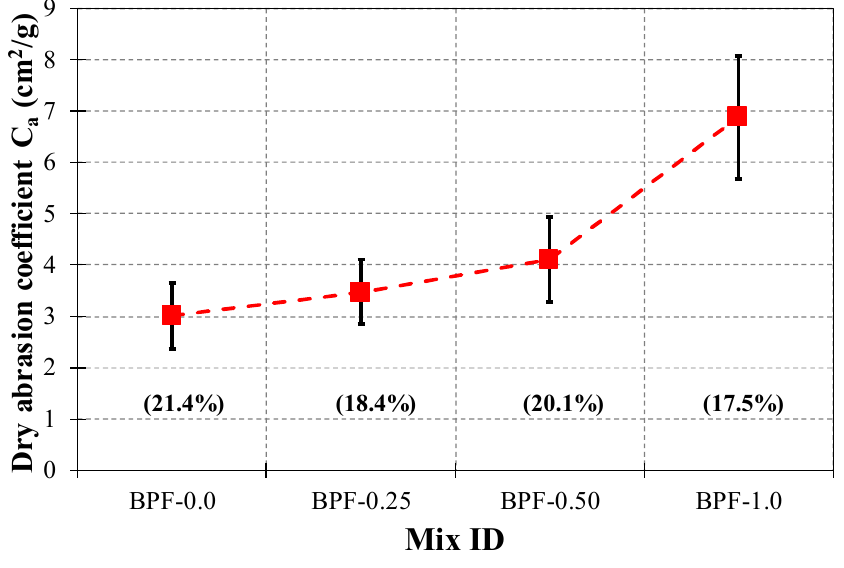
Figure 15. Representative images of the dry abrasion resistance of each earthen mix. Quantitatively, Figure 16 shows that the AV, SD, and COV values of the dry abrasion coefficient